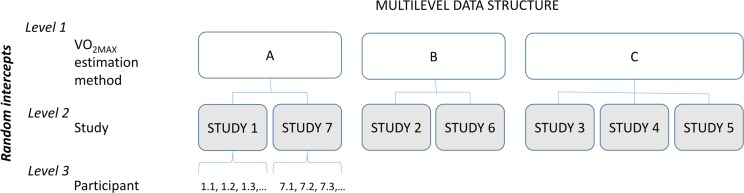
Schematic representation of the multilevel data structure.